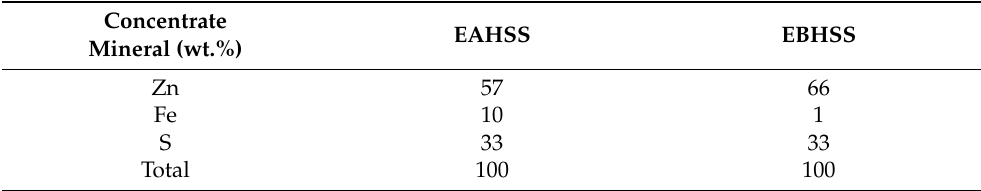
Table 1. Mineralogical composition of zinc concentrates. Concentrate Mineral